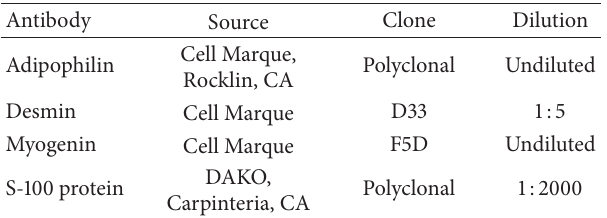
rhabdomyoblastic cytoplasm with large nuclei (Figure 2(a)). Table 1: Antibody sources and